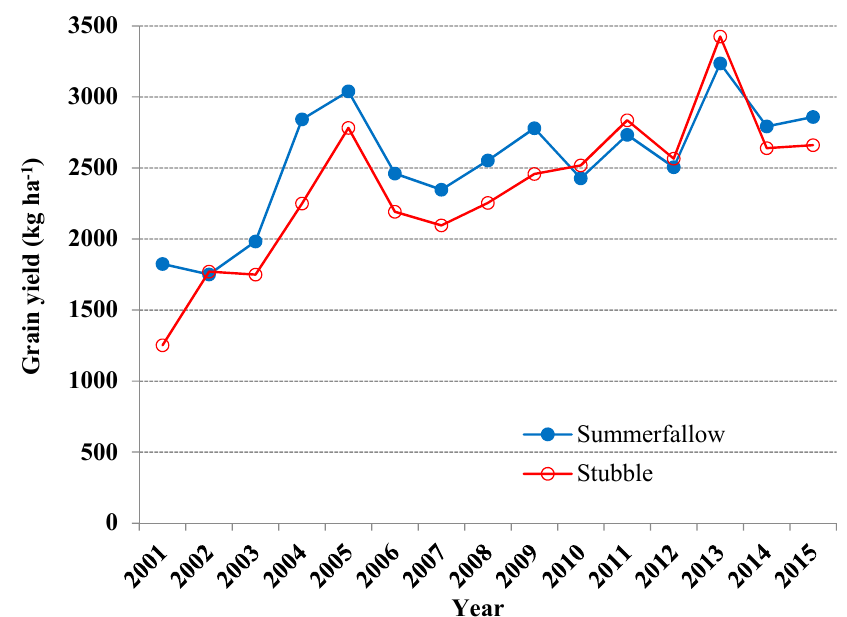
Figure 7. Average grain yield of durum wheat grown on summerfallow versus on stubble fields during 2001–2015 in Saskatchewan (Source: Saskatchewan Crop Insurance Corporation, n = 361,683 individual durum wheat growers (2001 to 2013) and Saskatchewan Crop Planning Guide in 2014– 2015).